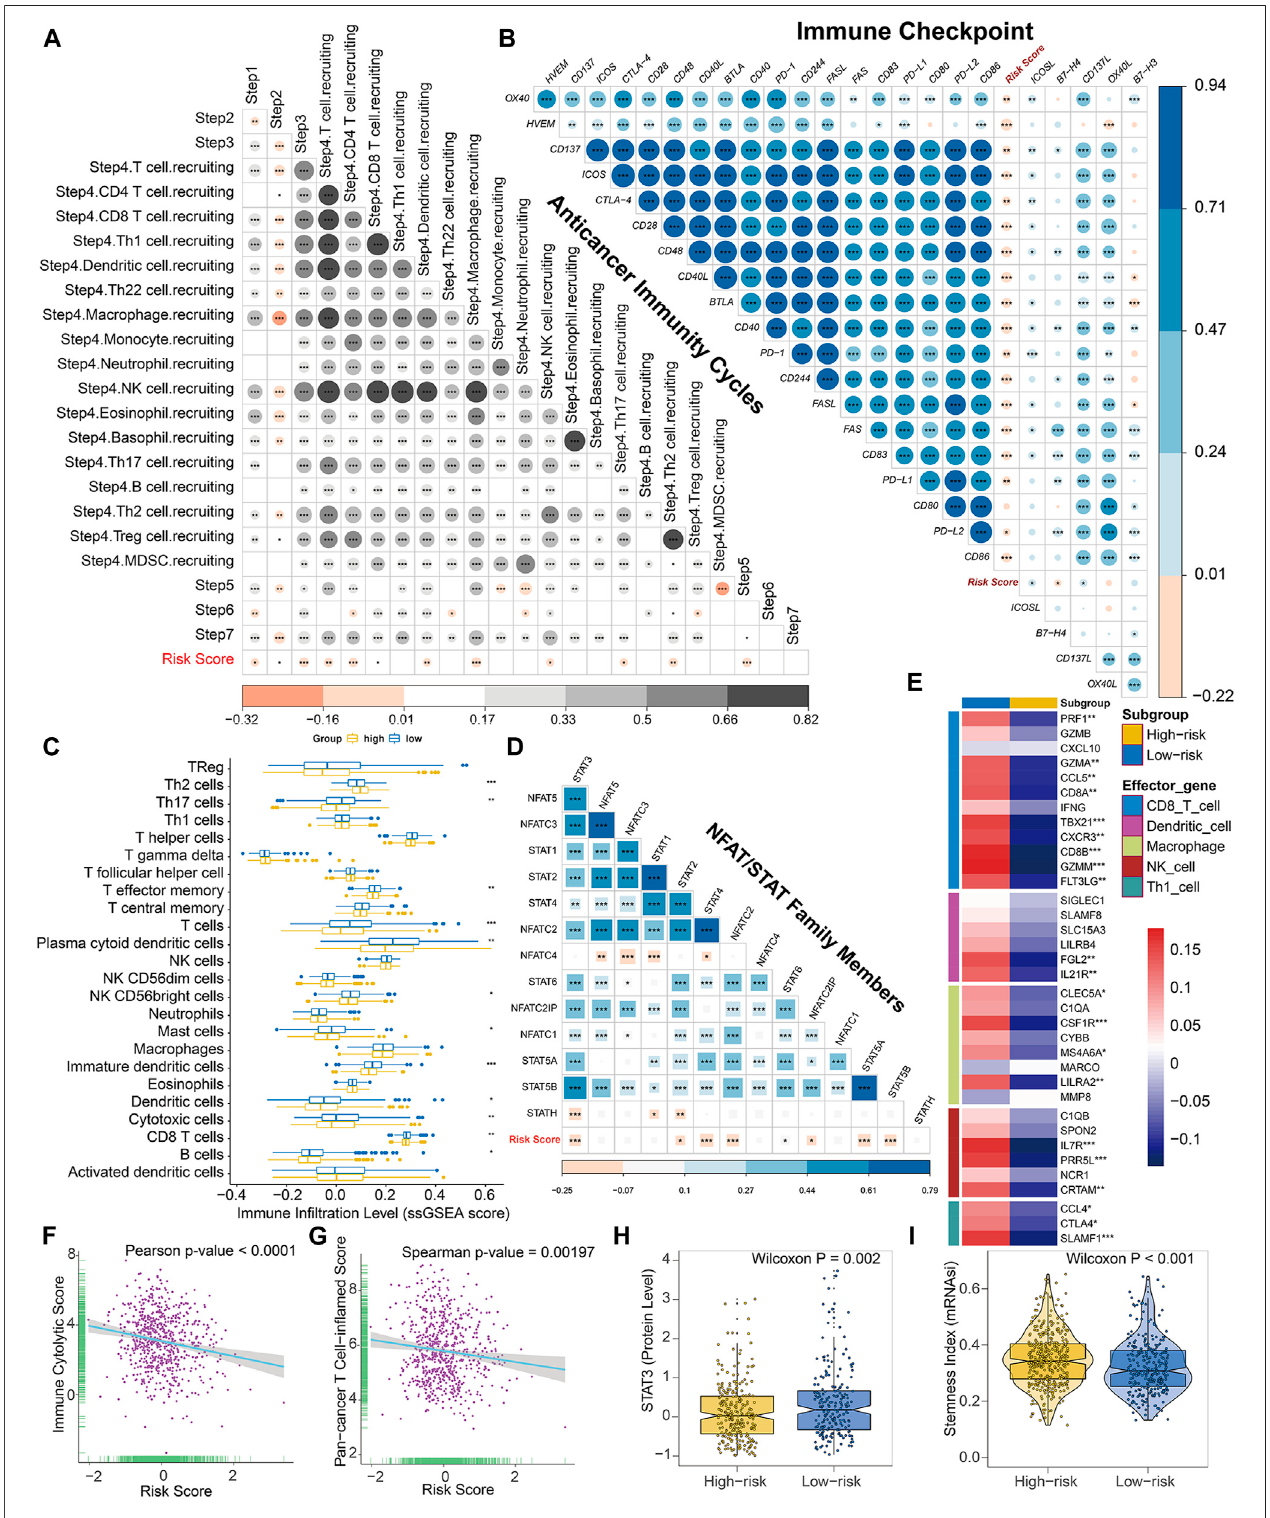
FIGURE 7 | The epigenetic risk score shapes a non-in fl amed TME in BC. (A) Correlation between risk score and enrichment scores of various steps of the anticancer immunity cycle. (B) Correlation between risk score and expression levels of 24 curated inhibitory immune checkpoints. (C) Differences in the in fi ltration levels of 24 immune cells (quanti fi ed by ssGSEA algorithm) between low- and high-risk subgroups. (D) Correlation between risk score and mRNA levels of NFAT and STAT